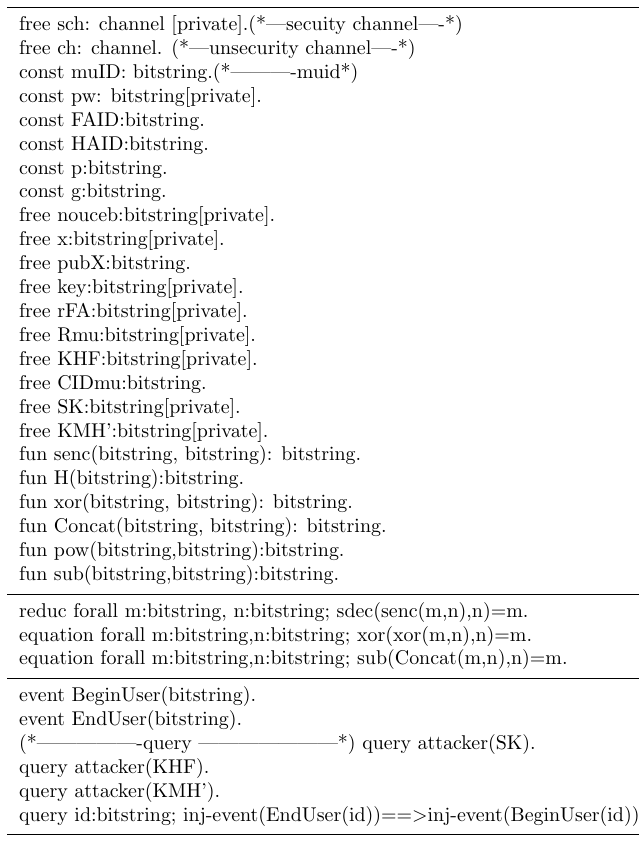
Figure 3. Predefinition